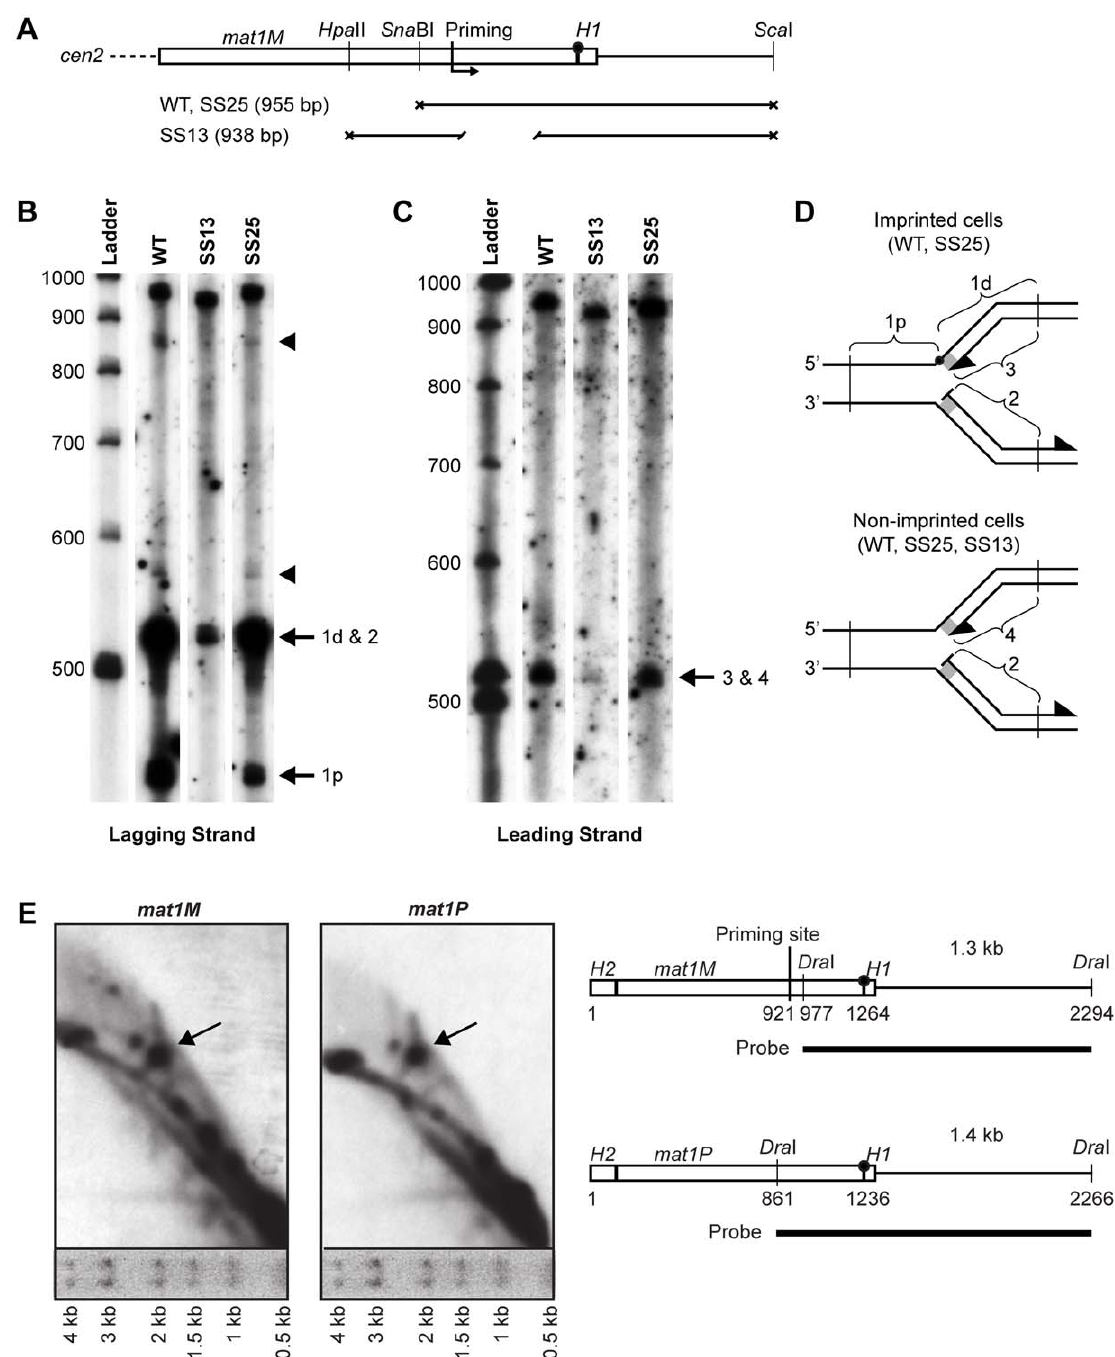
Figure 5. Southern analysis of mat1 replication intermediates. (A) Line drawing of the fragments generated for different strains for denaturing polyacrylamide gel electrophoresis (PAGE) analysis of replicating mat1M DNA shown in panels B and C. The positions of the restriction enzyme sites and the mapped priming site, and the lengths of the fragments are given. The site of the imprint is indicated with a circle. (B) Denaturing PAGE analysis of the mat1M lagging strand. Replicating DNA from log-phase cells was isolated as for 2D-gel analysis, digested with restriction enzymes given in panel A, then was subjected to denaturing PAGE analysis. After blotting, the membrane was probed with a strand- specific probe that hybridizes to the nascent lagging strand and the parental upper strand. Denatured and labelled DNA ladder is given to the left with size markers. The strains that exhibit imprinting (WT and SS25) produced two strong bands that correspond to the centromere-distal and proximal DSB products created by hydrolysis of the imprint (1d and 1p, respectively). Specific priming products at the site of the imprint (2) migrate to the same position as the distal DSB product observed for the WT and SS25 strains (1d). See panel D. Two fainter putative priming products that are shared between WT and SS25 are marked by arrowheads. (C) Denaturing PAGE analysis of the mat1M leading strand. The nascent leading strand and the parental lower strand were detected by the strand-specific probe. The co-migrating signals from the leading strand intermediates stalled at the imprint in WT and SS25 strains (3) and at MPS1 in the strain SS13 (4) are indicated. See panel D. Denatured and labelled DNA ladder is given to the left with size markers. (D) Line drawings of the replication intermediates observed in panel B and C are given. Fragments that produce bands in PAGE